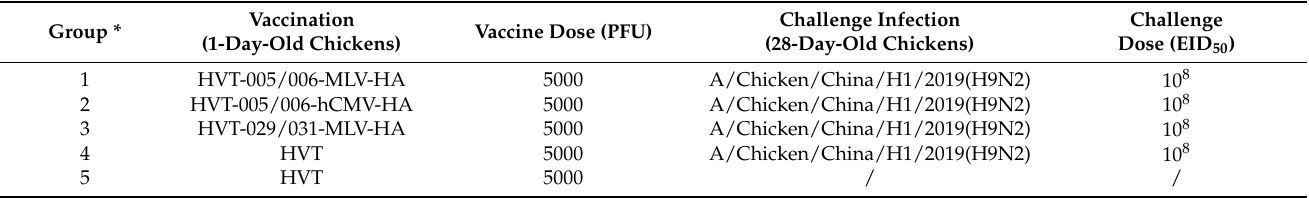
Table 1. Outline of the animal